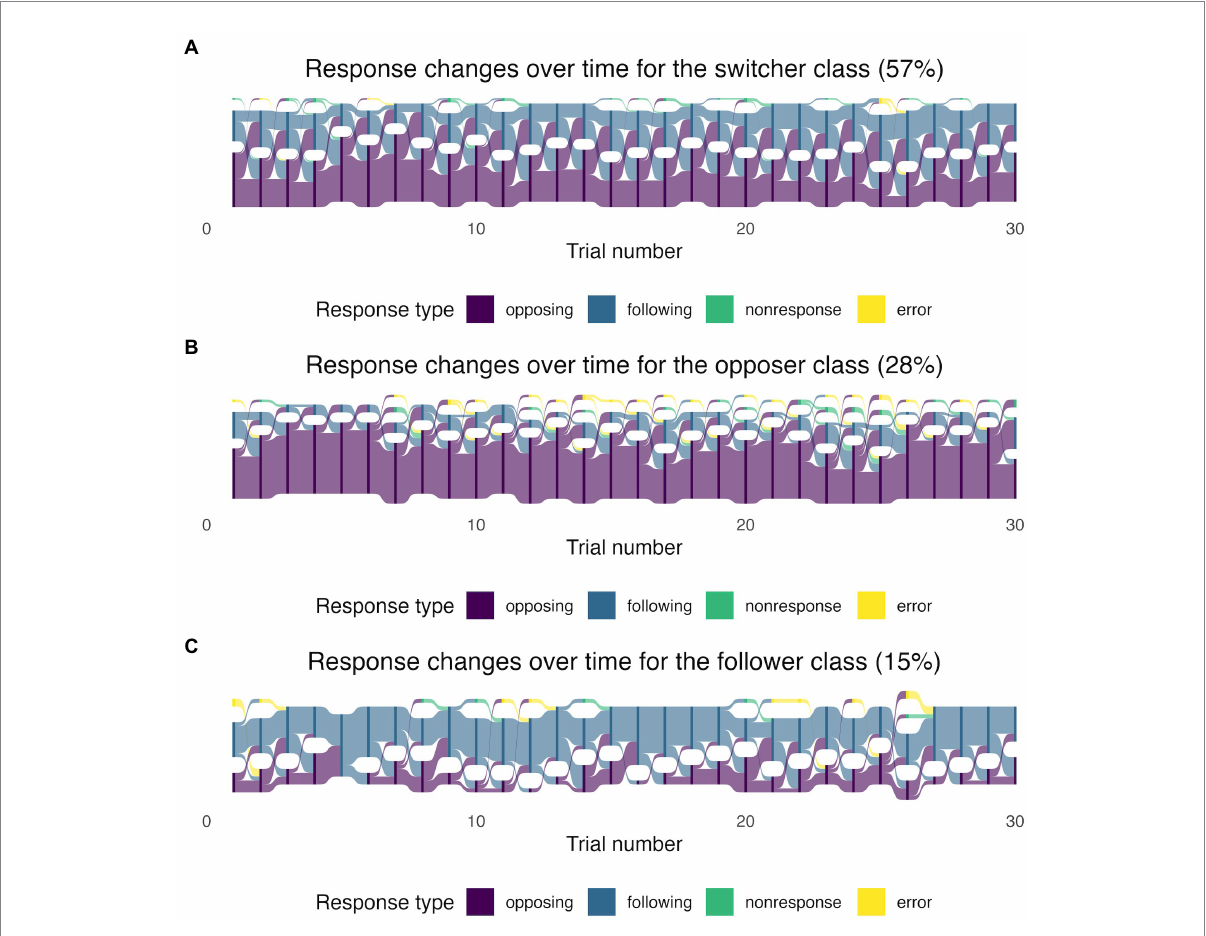
FIGURE 2 The Sankey diagrams of response-type proportions in the 30 trials based on the latent class membership: switchers (A) , opposers (B) , and followers (C) . The height of the nodes (dark purple, dark blue, dark green, and dark yellow) shows the frequency (counts) of each response type (coded in different colors) in each trial. The curves between the trials coded in light purple, light blue, light green, and light yellow represent the transitions from one response type to another. The width of the curves is proportional to the transition